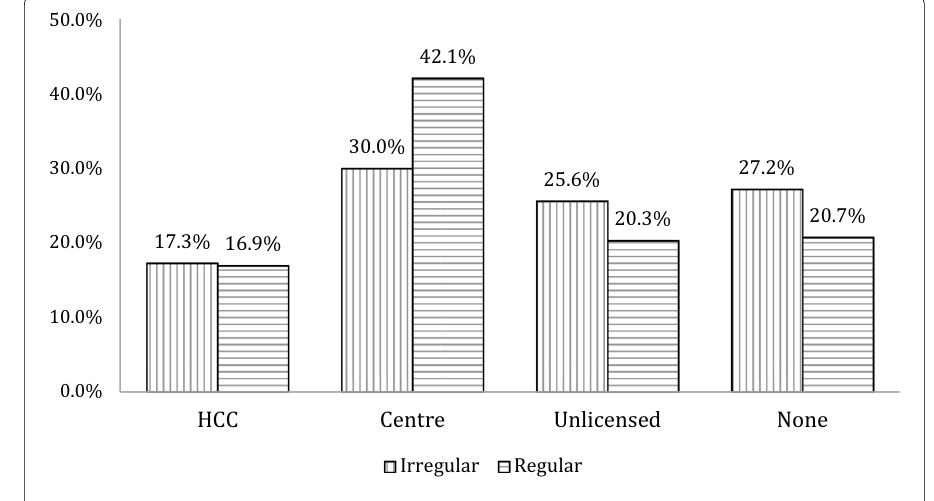
Fig. 2 ECEC type by family work schedule